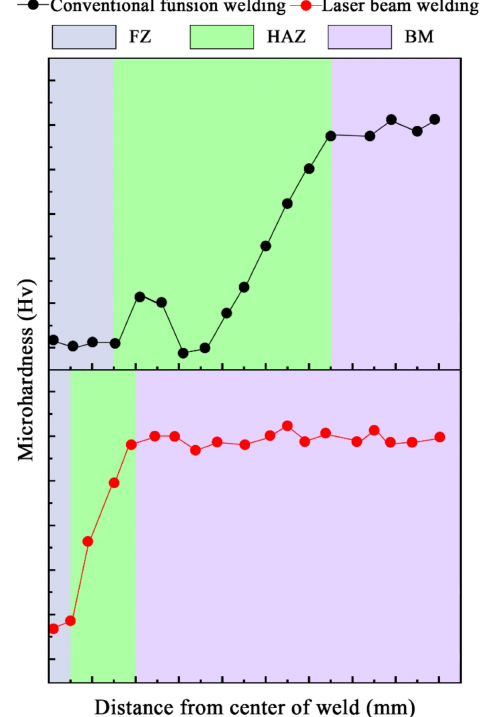
Figure 6. Typical microhardness distribution of AA7XXX series with T6 temper joint cross-section by conventional fusion welding and LBW (according to [70,73]).